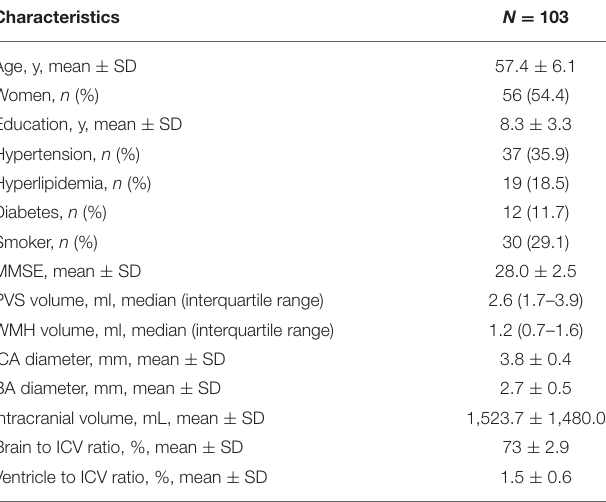
TABLE 1 | Characteristics of the study participants.